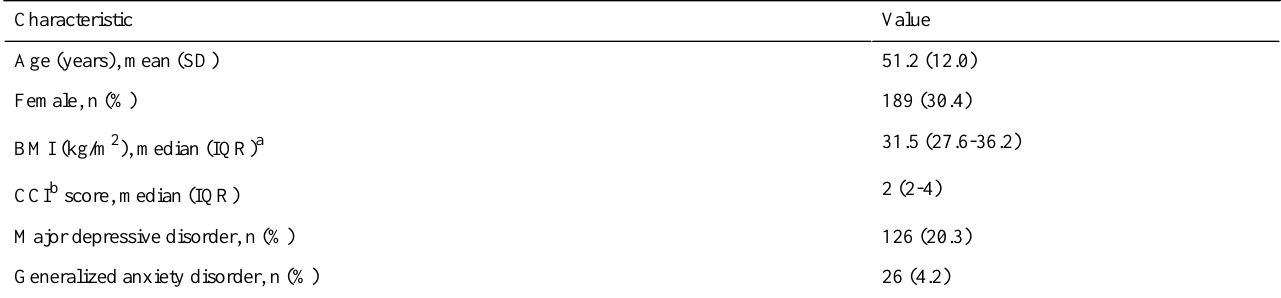
Table 2. Characteristics of patients (N=621).